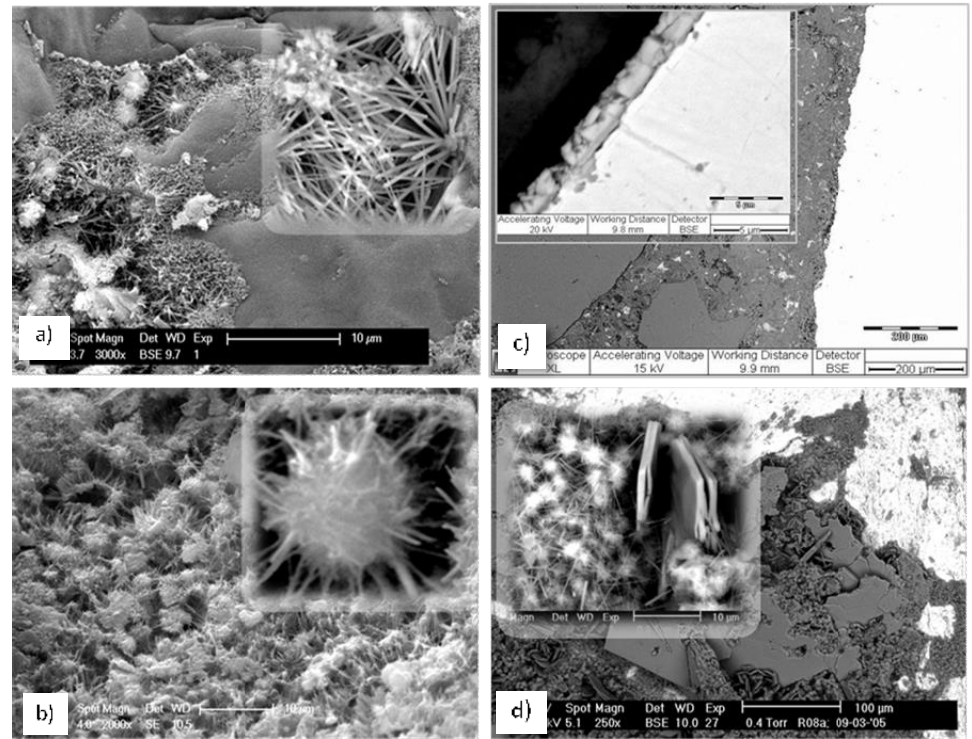
Figure 2. Electron microscopy (ESEM) micrographs, depicting the cement-based bulk matrix ( a , b ) and embedded steel ( c , d ) as follows: ( a ) a fracture of the interface aggregate (sand particle)/cement matrix, where the inlet depicts a hydration product (ettringite) of needle-shape morphology; ( b ) cement paste bulk matrix only—morphological observations on a fracture surface, depicting calcium–silicate hydrate (CSH) nucleation and growth; ( c ) the steel/cement-paste interface in reinforced mortar ( a polished cross section), where the following are well visible: the aggregate (sand particles) in the matrix, the cement paste bulk (in the proximity of the steel surface) and a well-adhered product layer (inlet) on the steel surface (the steel reinforcement appears on the right side of the image and in the inlet); ( d ) longitudinal section (top surface) of a steel reinforcement, partially covered with cement relicts and Ca-based compounds of platy morphology (CaO, Ca(OH) 2 ), together with CSH particles (inlet).